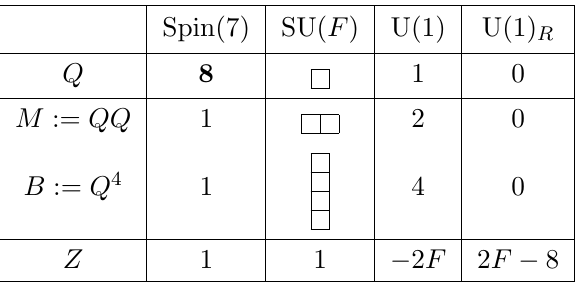
Table 2 . 3d N = 2 Spin(7) gauge theory with F